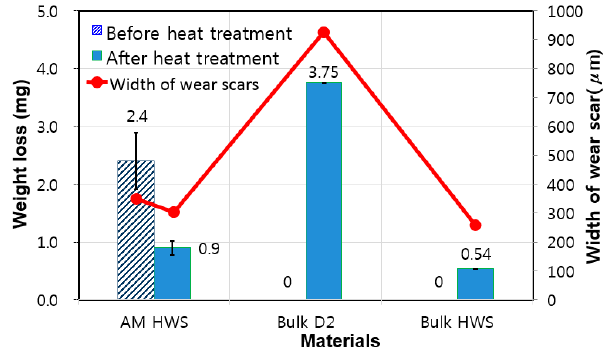
Figure 8. The wear-resistant comparison of the three materials.